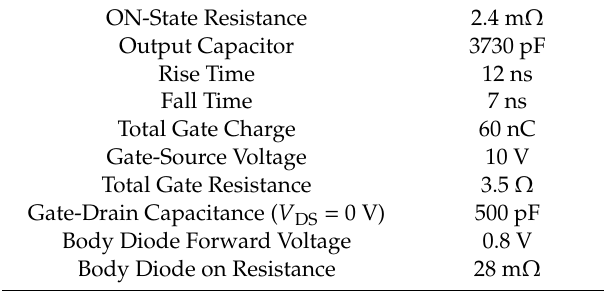
Table 2. General specifications of MOSFET FDMS86180, ON Semiconductor (Phoenix, AZ,